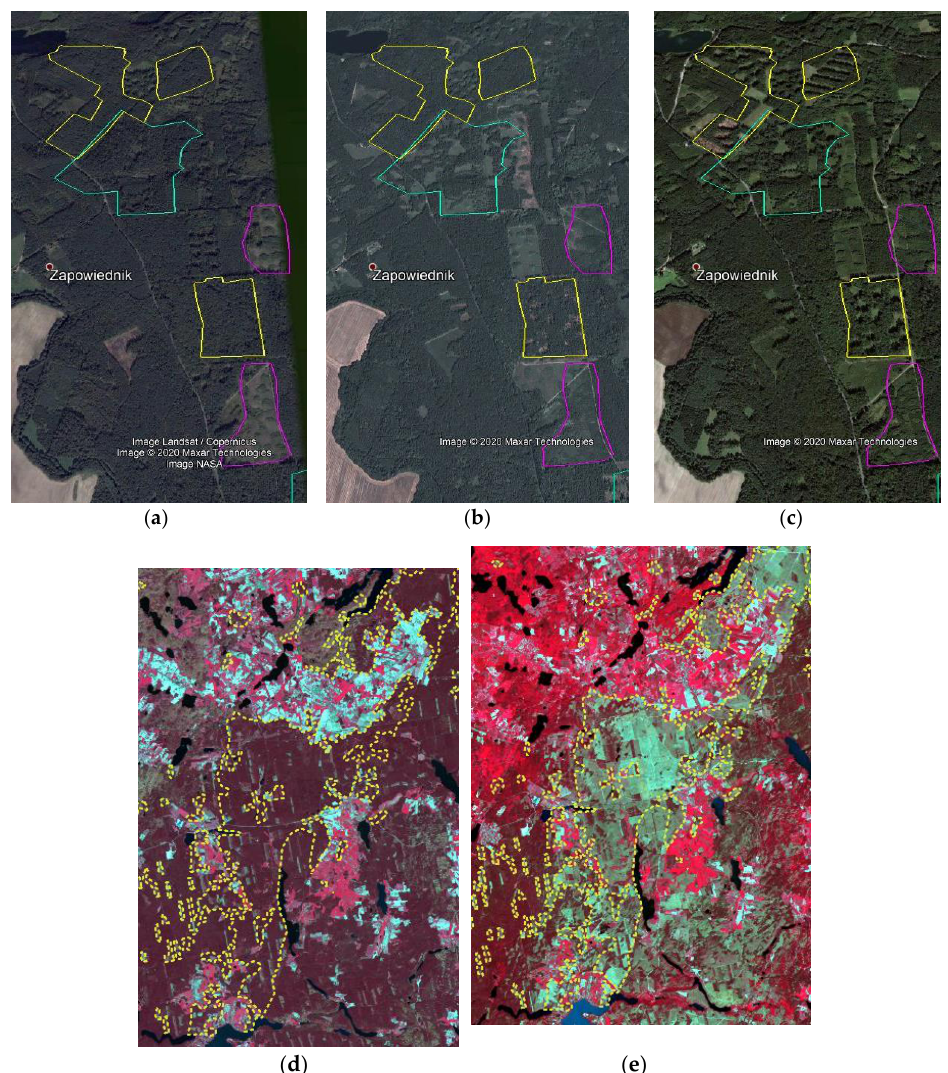
Figure 12. Coniferous forest in the Slupsk region: ( a ) 2006 –without clear-cuttings; ( b ) 2012 – green polygons indicate cutting conducted from 2006 to 2012; ( c ) 2018 – new cutting marked in yellow; ( d–e ) Bytow and Lipusz districts of Bory Tucholskie Forest CIR compositions, before ( d ) and after hurricane ( e ) in 2017.